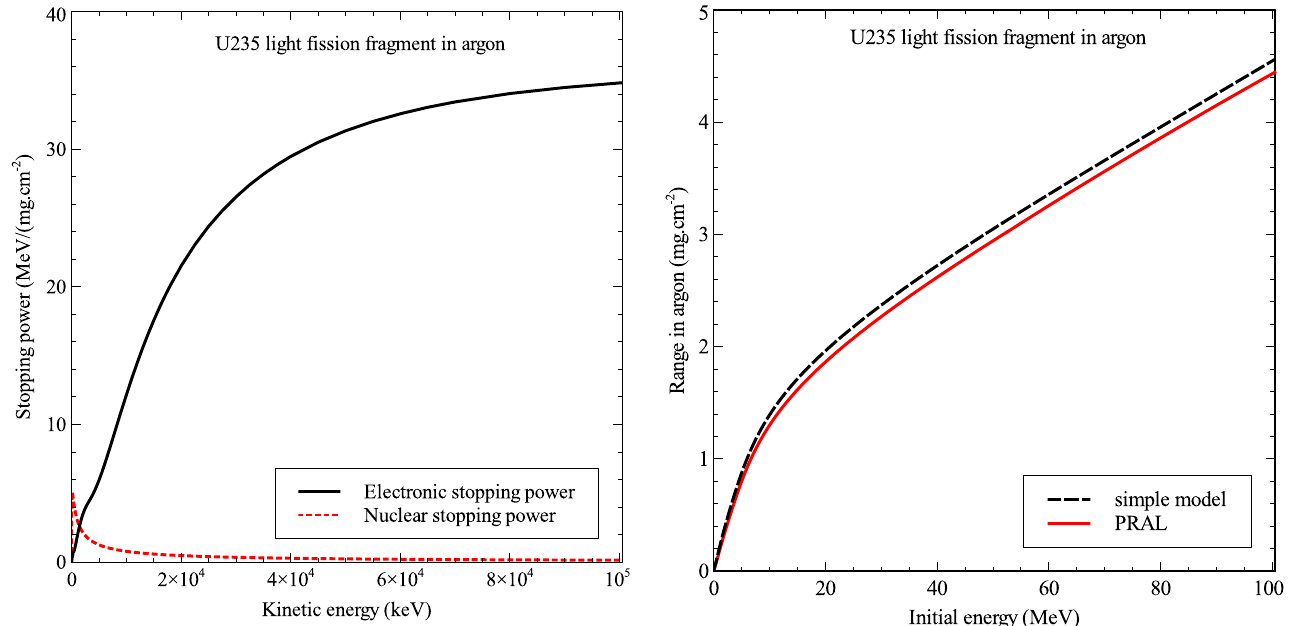
Fig. 6. Range as a function of energy computed with equa- tion (6) (simple model) and equation (8)